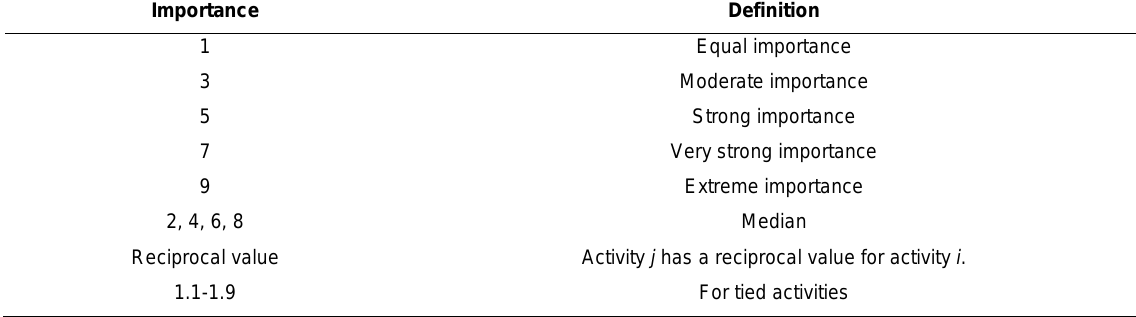
Table 2. Pairwise compression scale